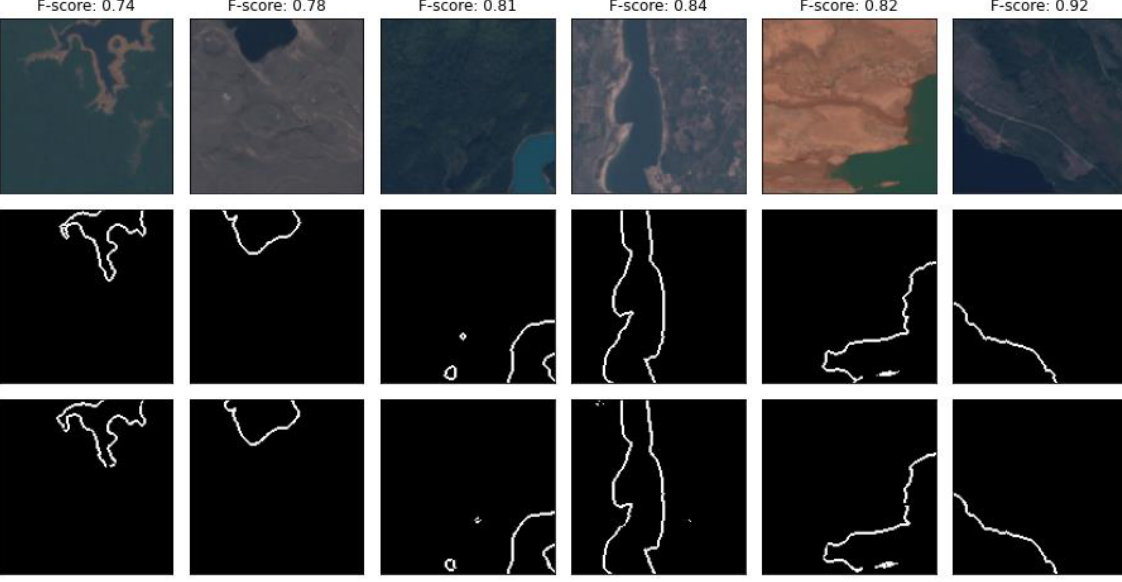
Figure 3. Results from Sentinel test data. The F-score for each image is at the top. The first row contains the original RGB image. The second row has the ground truth for each corresponding image. The bottom row has the predictions from the model trained on Sentinel